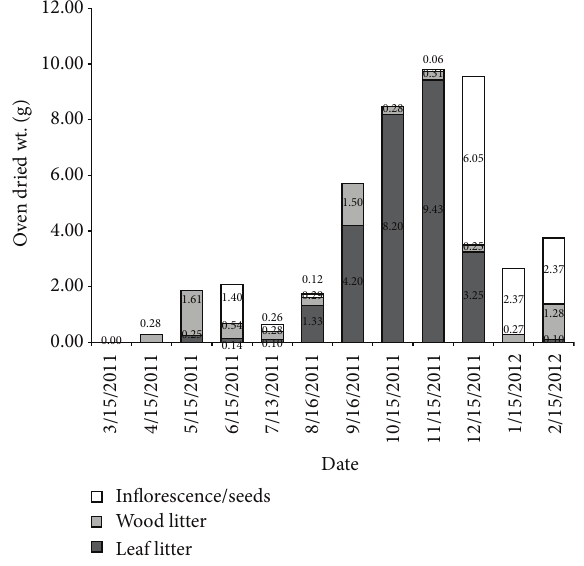
Figure 5: Partitioning of litter into leaves, wood, and inflores- cence/seed across different months in canopy gap.